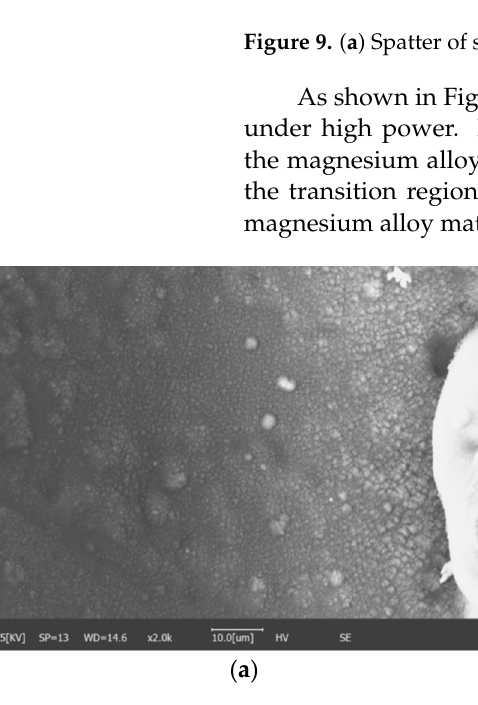
Figure 10. (a) Heat-affected zone transition area; ( b ) silicon carbide particles in the transition zone of heat-affected zone.